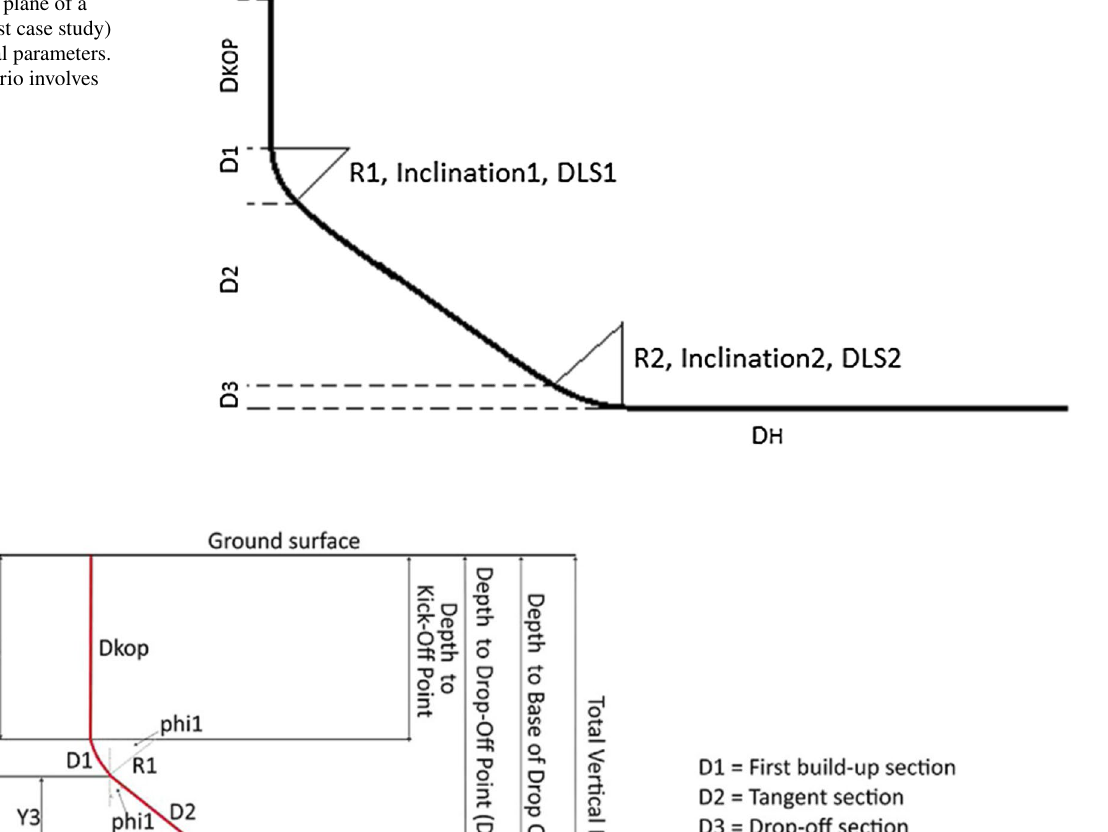
tion and a drop-off section separating the build sections. The wellbore trajectory formulation incorporates all the sections identified in